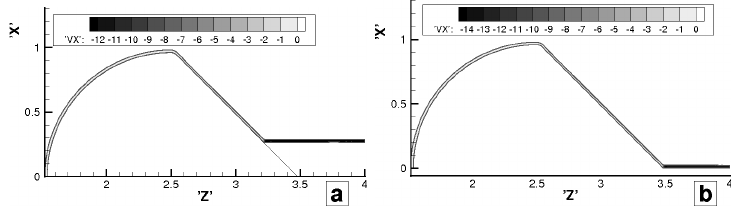
Figure 9. The elasto-plastic liner positions for different times ( t = 0 . 092; 0.124 ms).